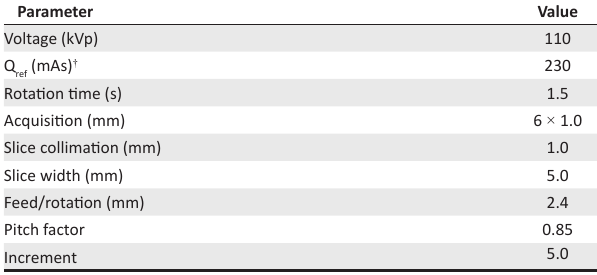
TABLE 1: Summary of scan parameters of the Somatom Emotion™6 multi-detector CT scanner used in the present